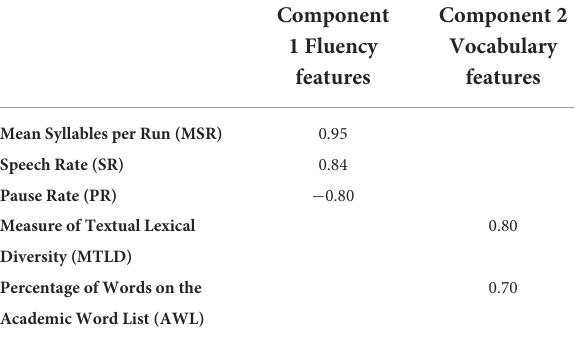
TABLE 5 Component loadings for speakers rated as 50 (after promax